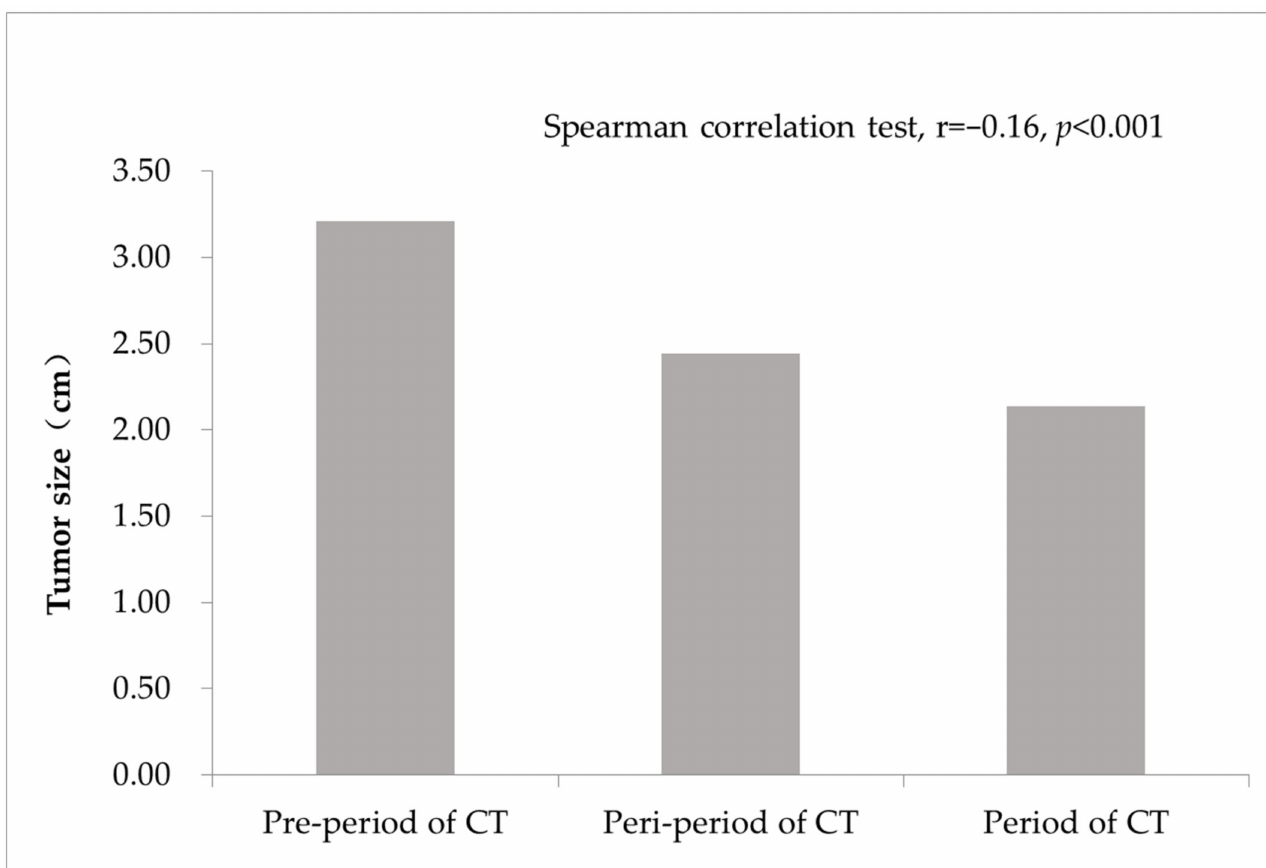
Figure 1. Tumor size of lung cancer diagnosed during the COVID-19 pandemic. Among patients with adenocarcinoma, the proportion of stage I was 61% at the pre- period of CT examination and increased to 70% at the peri-period of CT examination and 79% at the period of routine CT examination (Table 2). The increasing trend